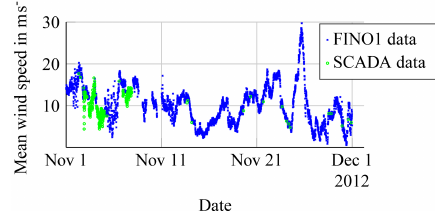
Figure 7. Example wind speed data after the post-processing.